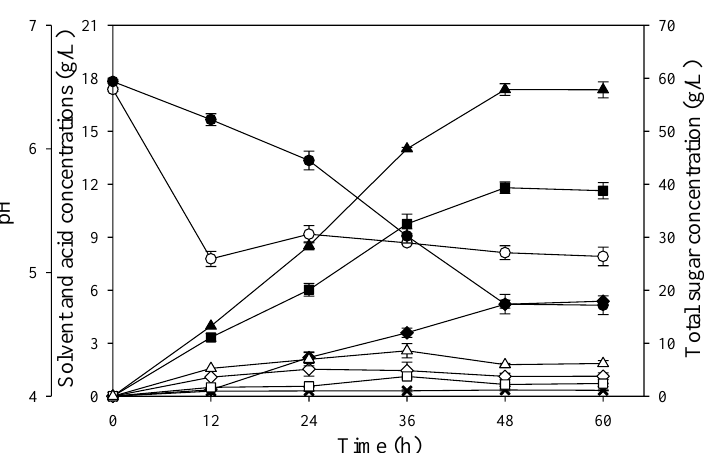
Figure 11. Batch butanol fermentation profiles from the SSJ medium by immobilized C. beijerinckii